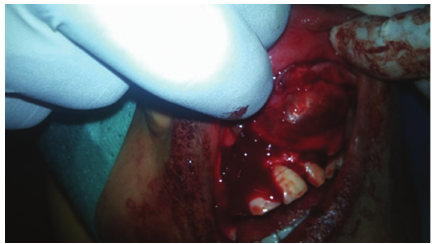
Figure 3: Intraoperative photograph showing the procedure under- taken for the removal of tumour.